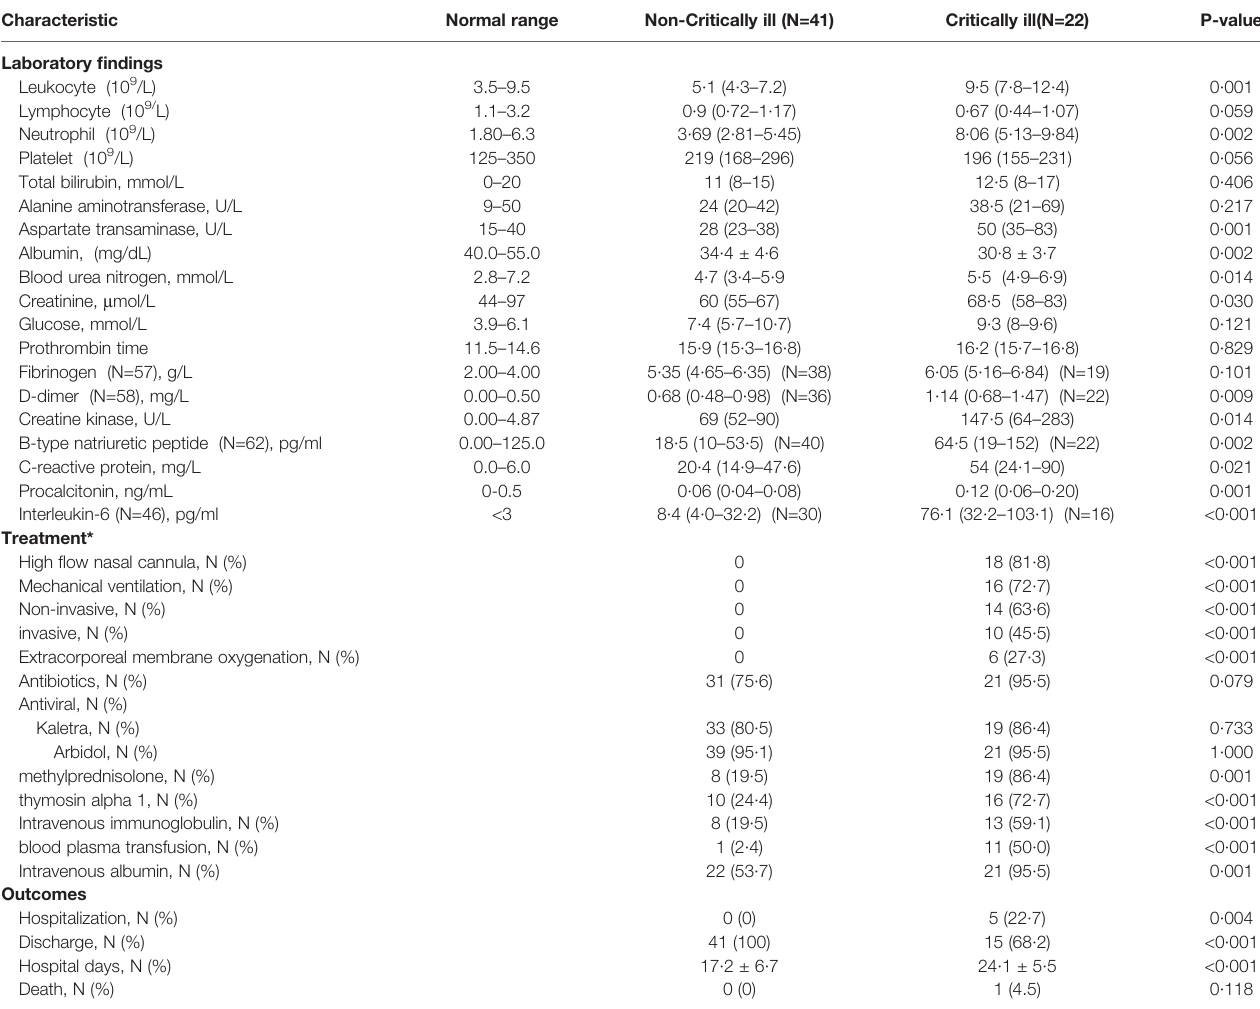
TABLE 2 | Comparison of laboratory fi ndings, treatment measures and clinical outcomes between critically and non-critically ill COVID-19 pneumonia patient groups. Characteristic Normal